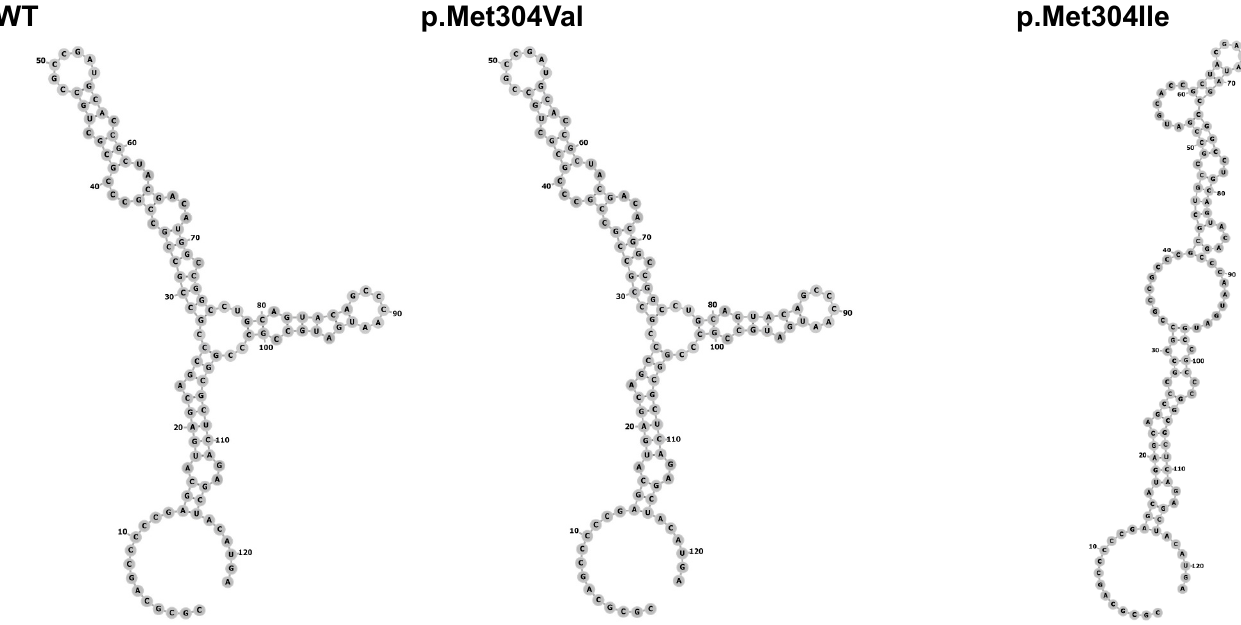
Figure 3. SOX3 mRNA structure change. While the p.Met304Val variant maintains the same structure as the wild type (WT) variant, the p.Met304Ile, present in the patient, loses a hairpin formation in the mRNA.